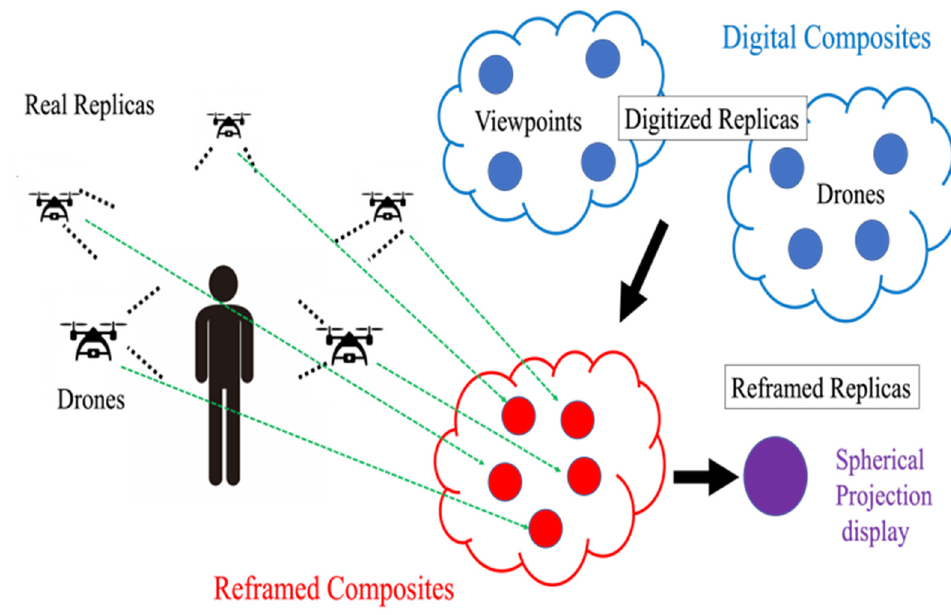
Figure 7. Multi-Viewpoint Aerial Projection.